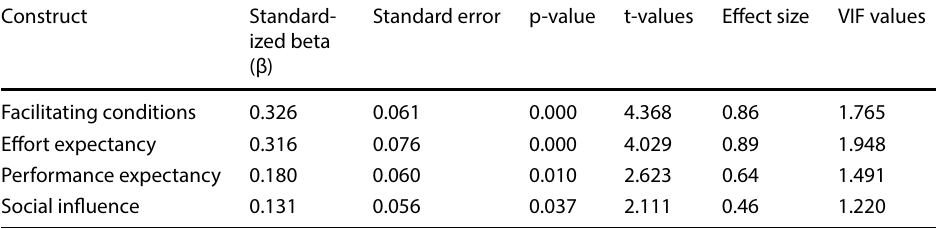
The significance level for the relationships is at α